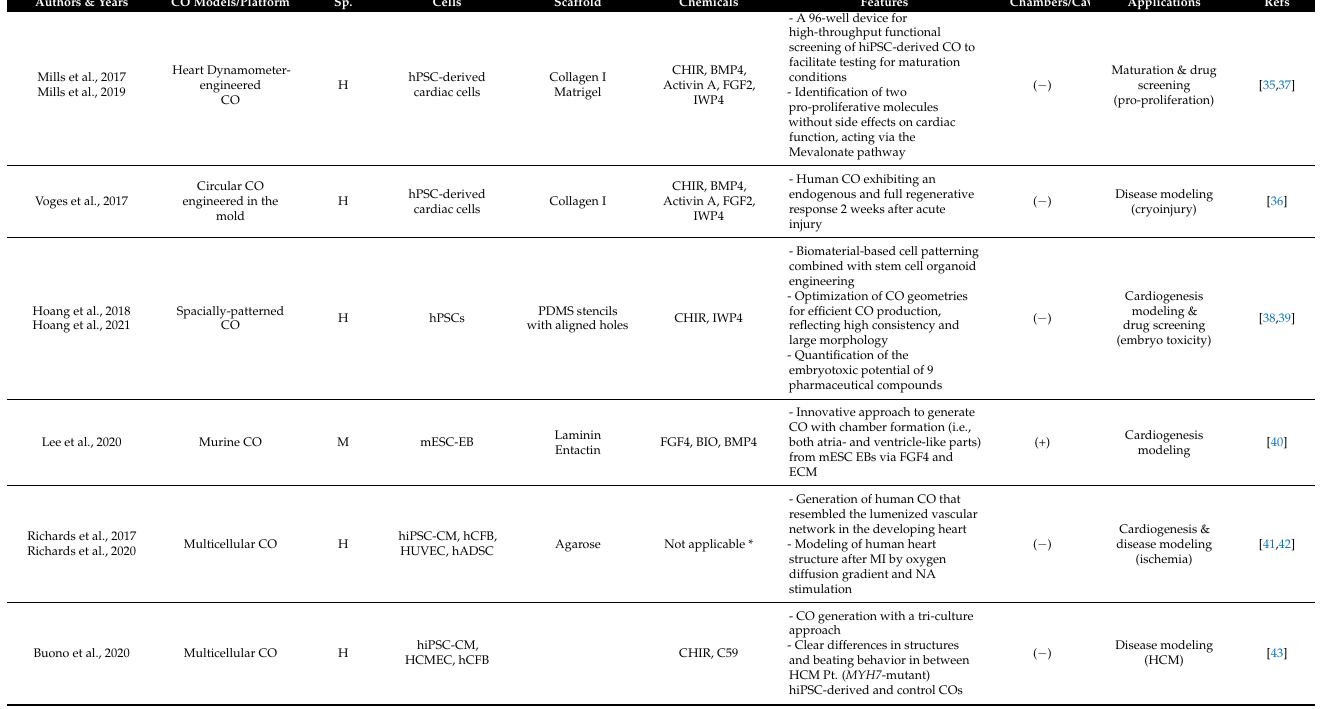
Table 1. Overview of cardiac organoid models in an early era